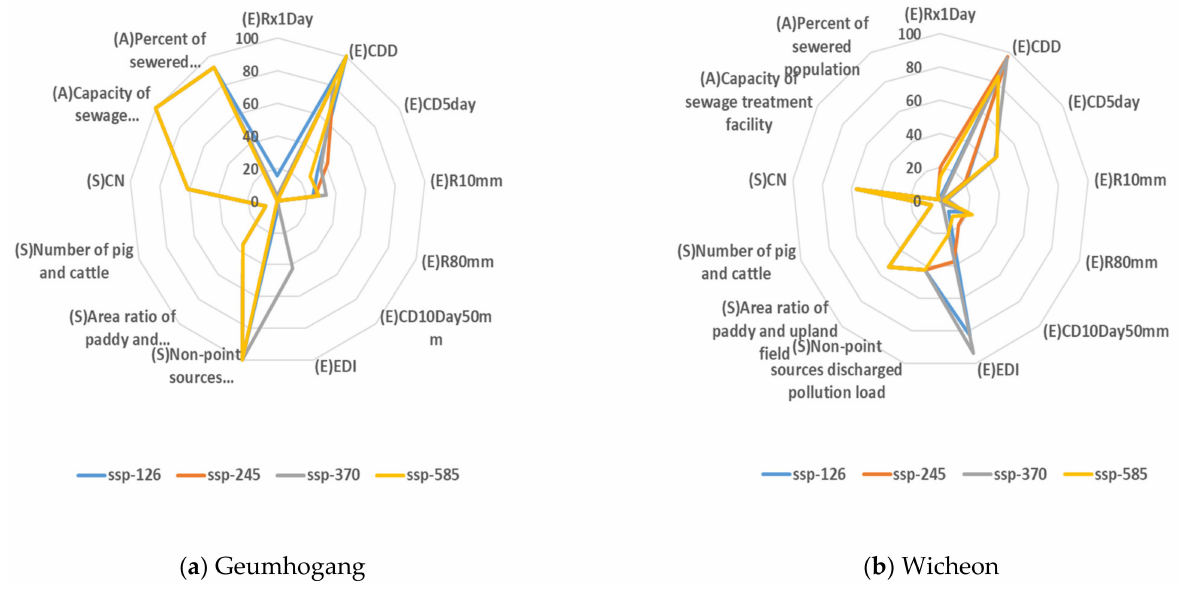
Figure 4. Analysis of sensitivity by proxy variable for each scenario (( a ) is the Geumhogang sub- watershed with the highest CCVI and ( b ) is the Wicheon sub-watershed with the lowest